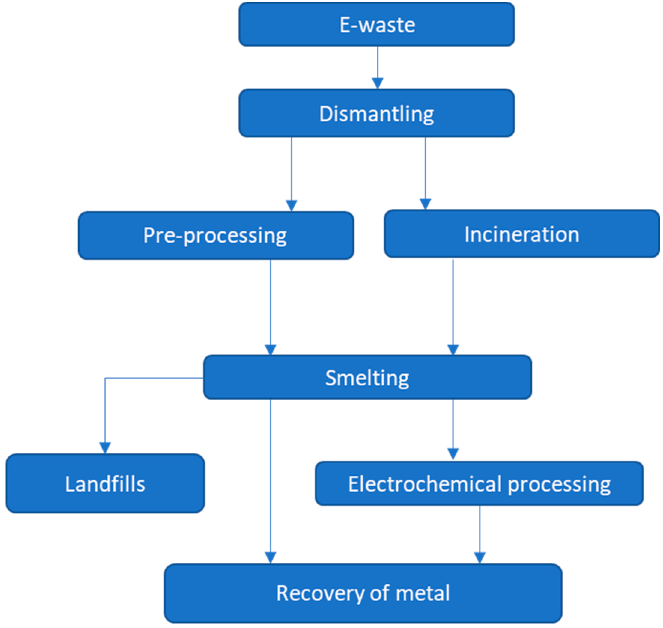
Figure 7 . A pathway for recycling precious metals from e-waste via the pyrometallurgy process [79].